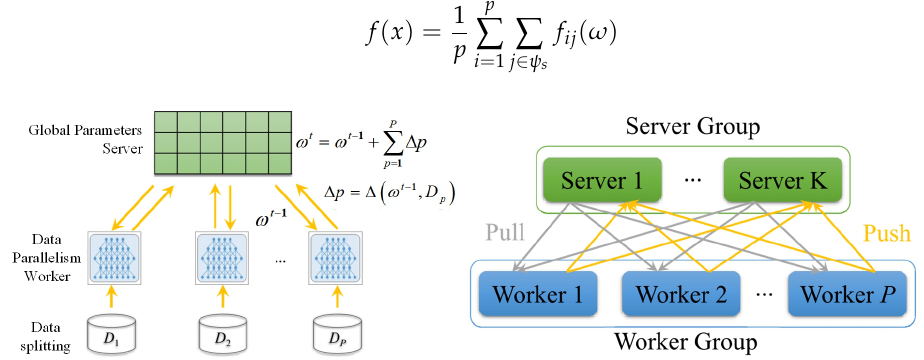
Figure 1. Distributed topology